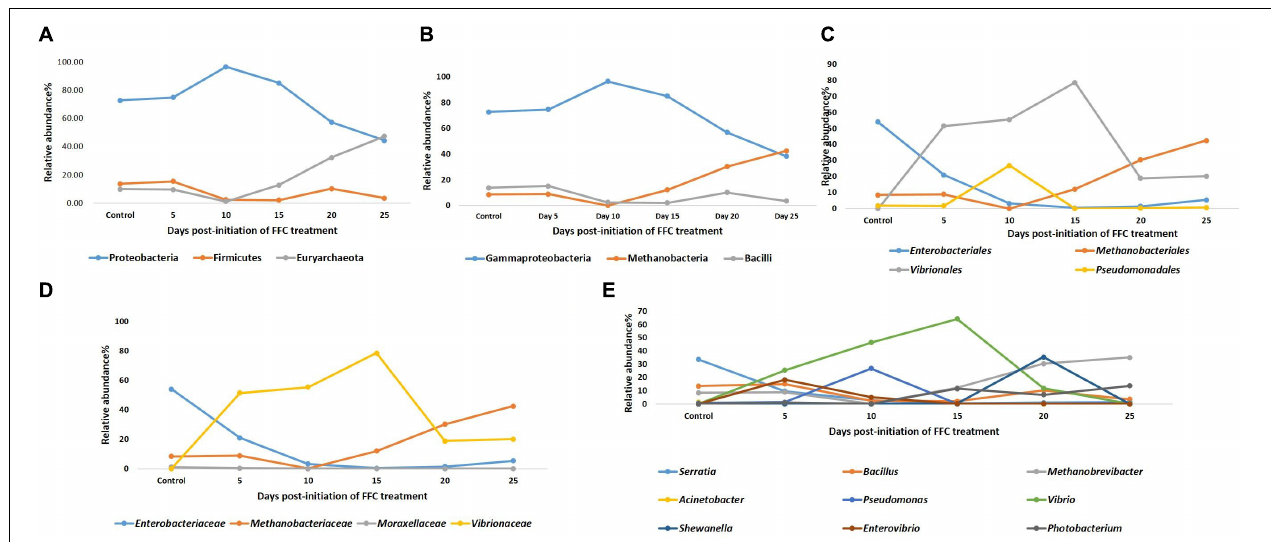
FIGURE 6 | Dynamics of microbial taxon whose relative abundance was significantly altered by FFC treatment. (A) At phylum level; (B) at class level; (C) at order level; (D) at family level; (E) at genus